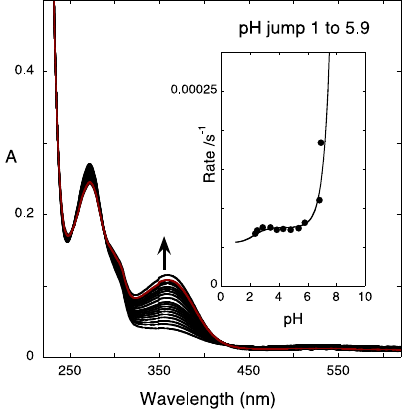
Figure 7. Spectral variations regarding the slowest step to attain the equilibrium, which is controlled by the cis-trans isomerization. The increase in the rate for pH > 6 take place from the ionized species and was not used in this calculation, which restrains to the moderately acidic pH range. With permission from RSC reference [15].